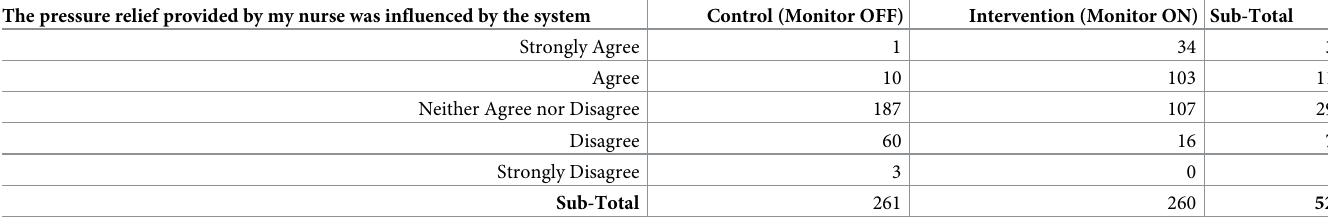
Table 4. Distribution of responses between the control and intervention groups to the statement, “the pressure relief provided by my nurse was influenced by the system”. The pressure relief provided by my nurse was influenced by the